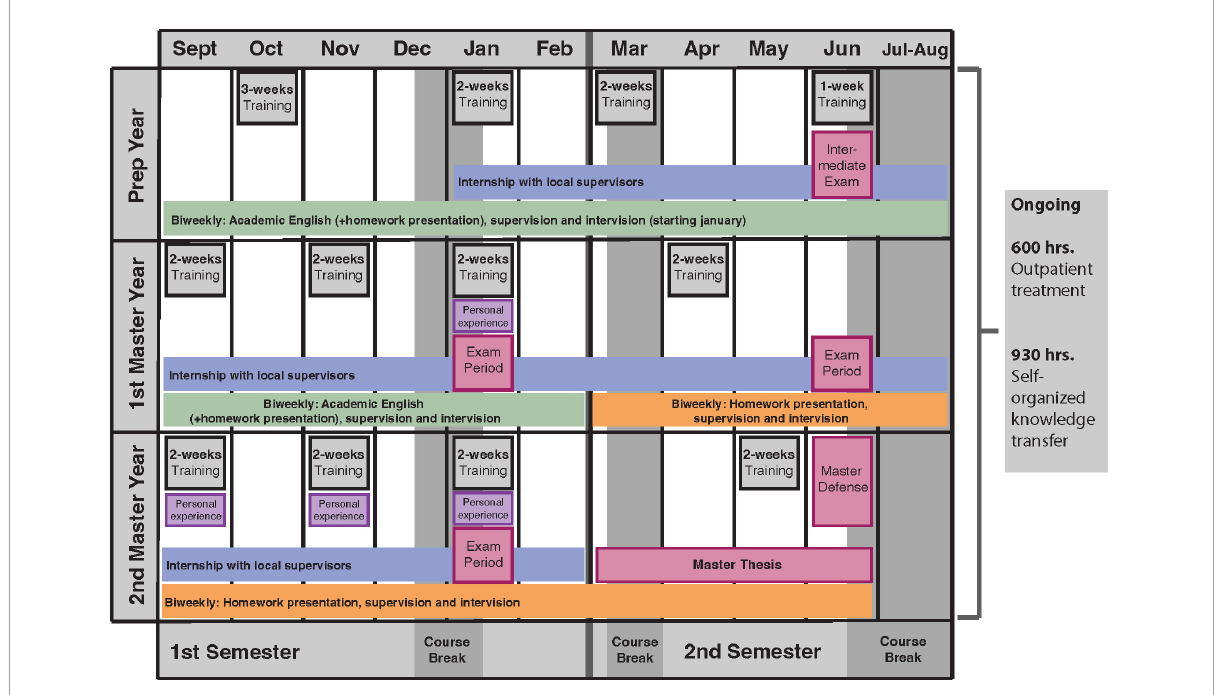
FIGURE1 Course program for the 1st and 2nd